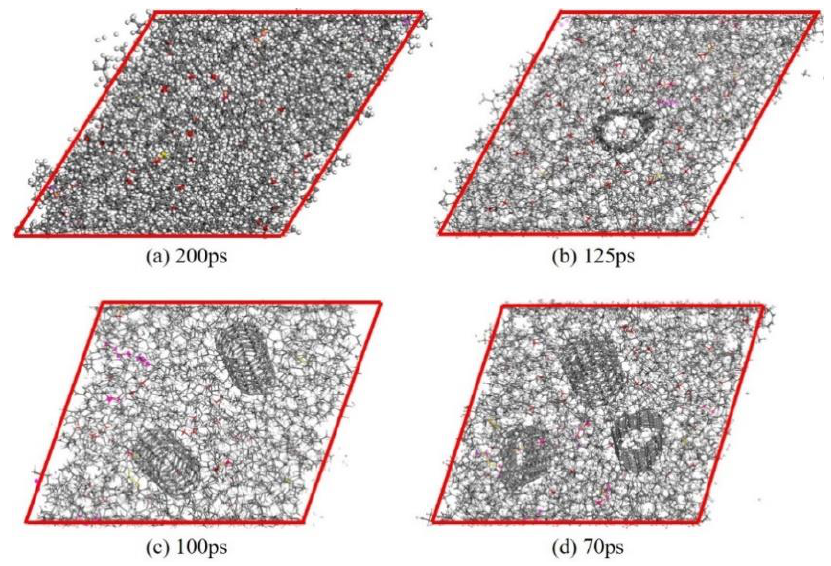
Figure 12. Deformation state of different CNT/VNR composites and time at the beginning of slipping. ( a ) Pure VNR. ( b ) 5 wt.%CNT/VNR composite. ( c ) 10 wt.%CNT/VNR composite. ( d ) 15 wt.%CNT/VNR composite.